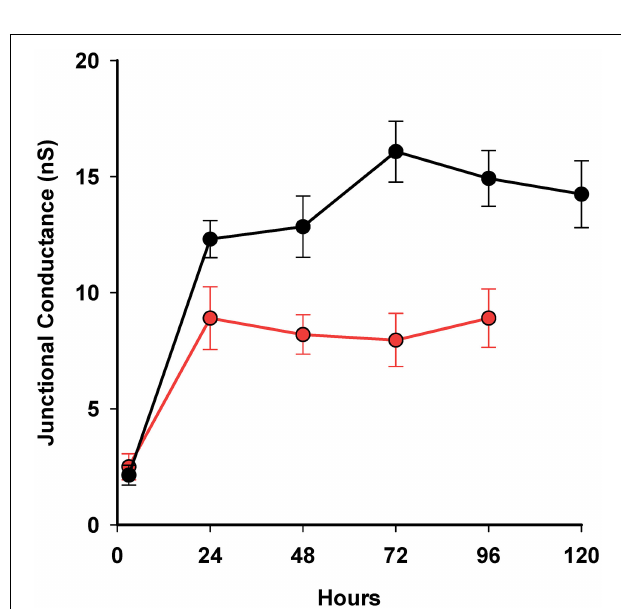
2010). Filled circles are the data shown in A . All data points are from four different cell pairs exposed 4PB (5mM) for 24h ( n = 4). Boltzmans fit of the 4PB data set yielded a V o of 67mV, a g min of 0.33. The dashed line represents a Boltzmans fit of control data with the following parameters: V o = 67mV and g min = 0 . 31.